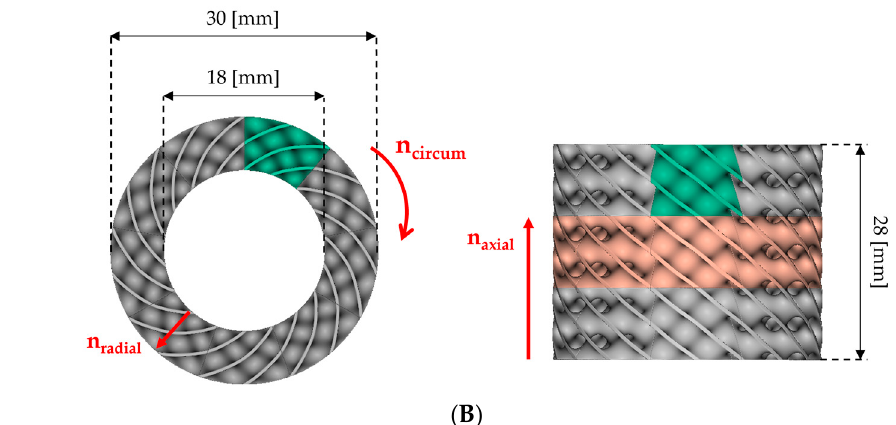
Figure 2. Project of Diamond TPMS cylindrical structures on example Diamond_9_1_0.64 structure: ( A ) unit cell (top and side view); ( B ) geometrical dimensions (top and side view; green color- single unit cell; orange color- single layer of unit cells).